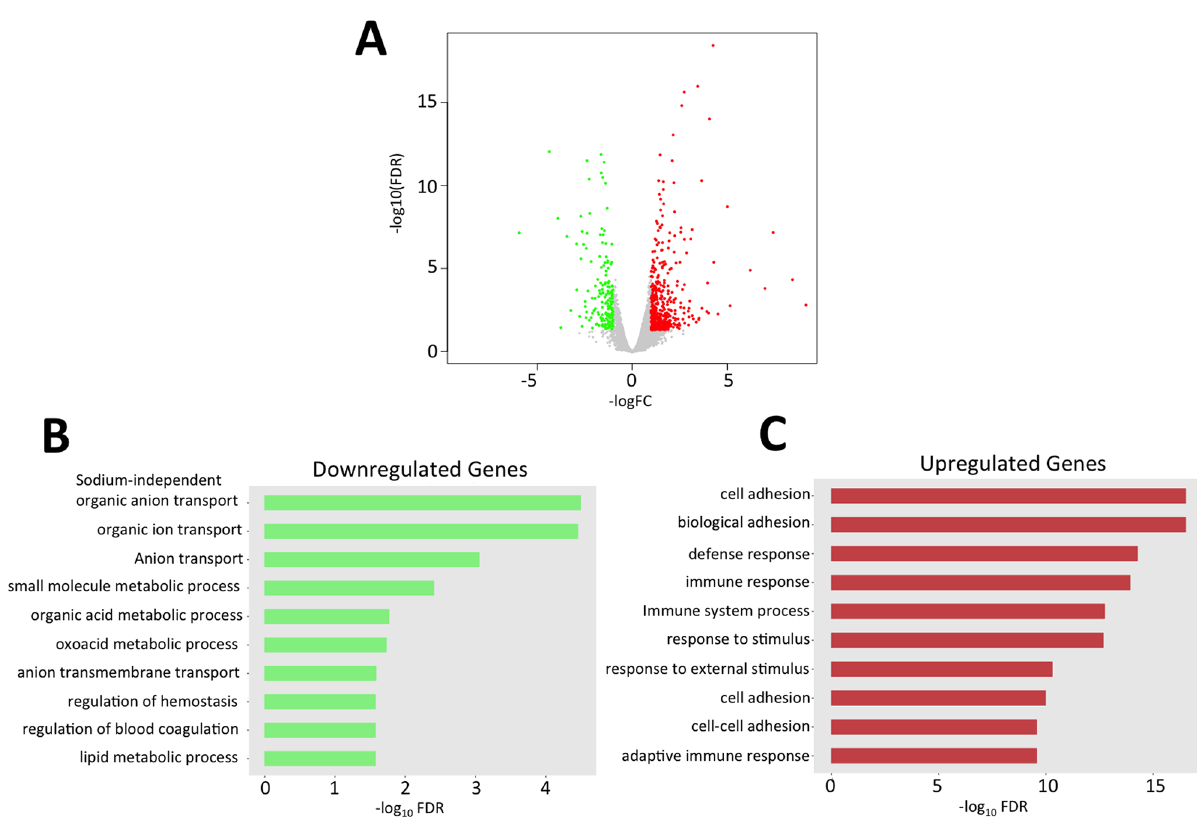
Fig 4. Differences in gene expression between Fnip1 -/- versus wildtype kidney tissue. RNAseq was performed on kidney cortical tissue from Fnip1 -/- (n = 3) and wildtype (n = 3) mice (11–18 weeks of age) using Illumina HiSeq 2500. (A) Volcano plot generated using EdgeR program showing genes significantly increased (red) and decreased (green) in Fnip1 -/- kidney versus WT kidney tissue. Gene ontology analyses derived from Bioconductor Open Source Software for Bioinformatics showing: (B) significantly downregulated genes grouped by expression levels and gene function in Fnip1 -/- compared to WT renal tissue, and (C) significantly upregulated expression of genes grouped by expression levels and gene function in Fnip1 -/- compared to WT renal tissue. The majority of significantly decreased genes were involved in ion transport and metabolism, whereas the majority of significantly increased genes were involved in cell adhesion and immune